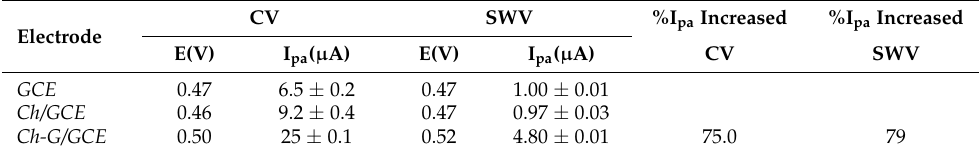
Table 2. Anodic peak currents for MR with GCE , Ch/GCE , and Ch-G/GCE by CV and